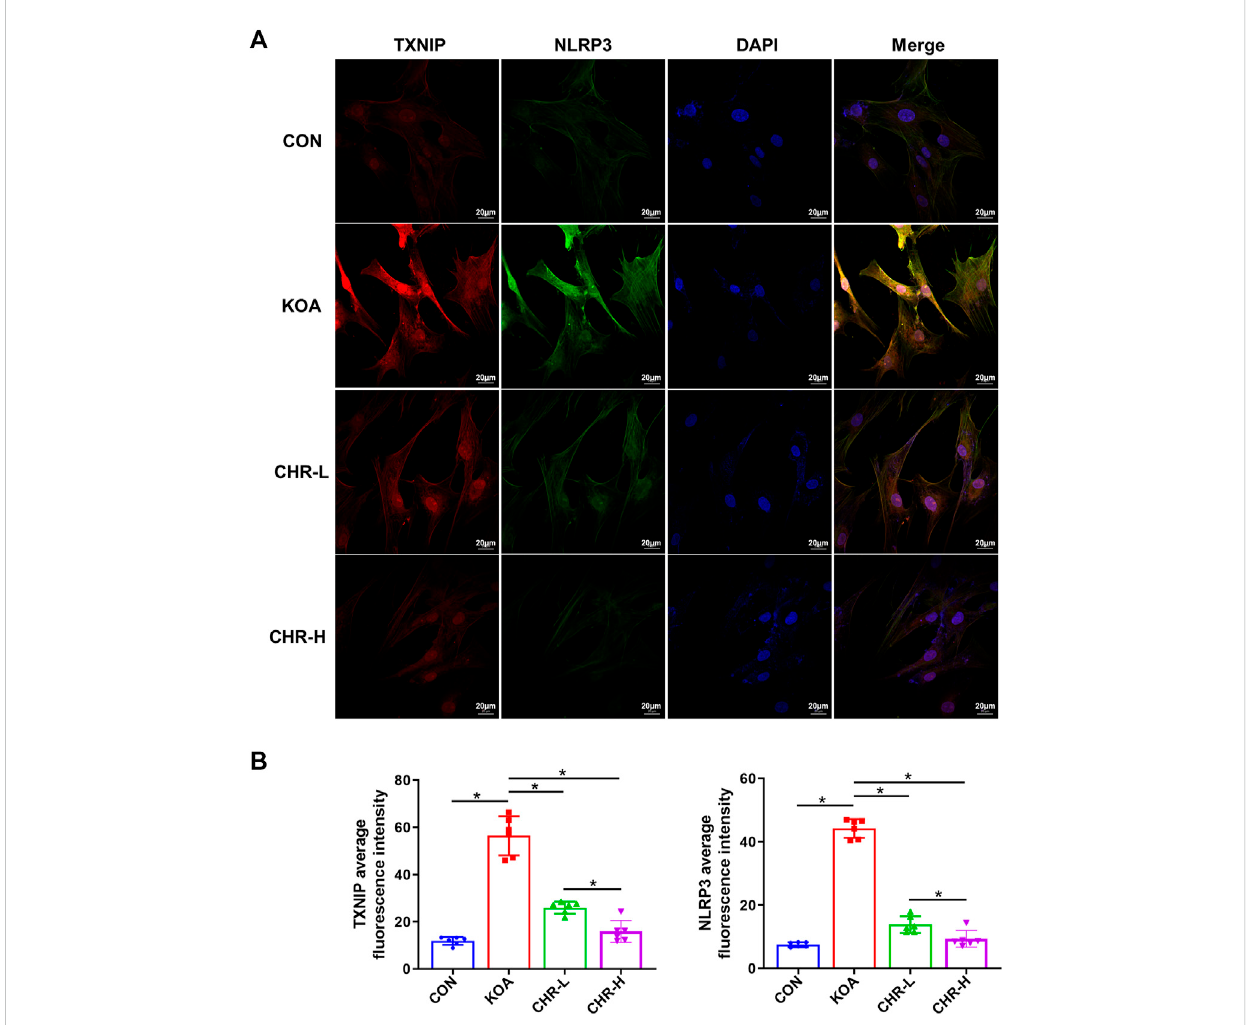
CHR prevents the colocalization of TXNIP and NLRP3 in TGF- β -induced SFs. (A) Confocal microscopic images of treated SFs that were immunostained with anti-TXNIP (red), anti-NLRP3 (green), and DAPI (blue). (B) Double immuno fl uorescence colocalization of TXNIP